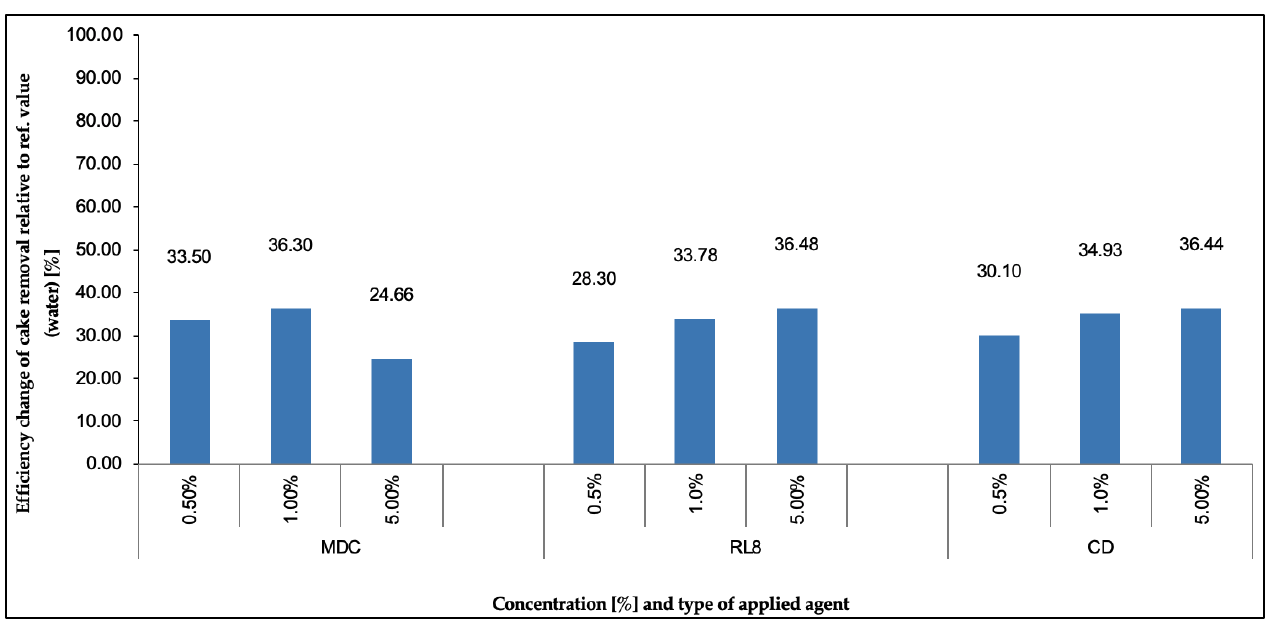
Figure 6. Percentage change in the efficiency of mud cake removal with traditional fluids compared with the reference value of water (55.42%).